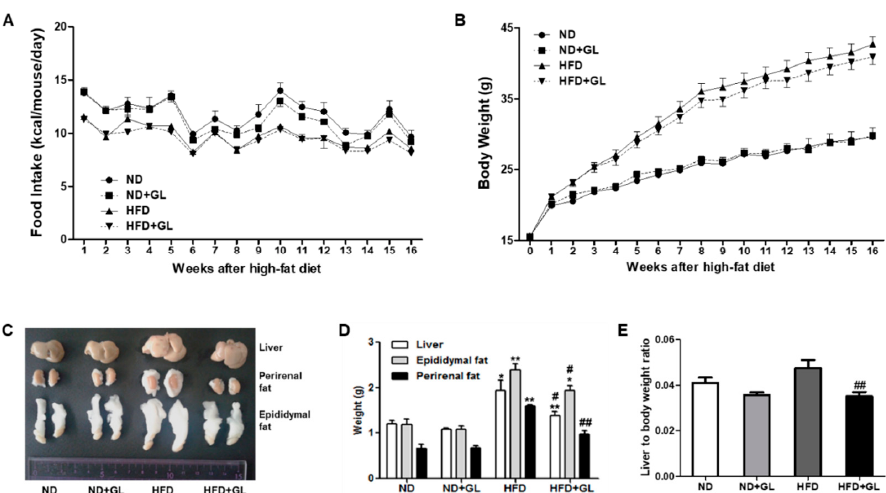
Figure 1. Ganoderma lucidum (GL) attenuated the increase in liver weight and epididymal and perirenal fat accumulation in high fat diet (HFD)-fed mice. ( A ) Food intake and ( B ) body weight for 16 weeks. ( C ) Representative images of liver, perirenal fat and epididymal fat and ( D ) the changes of the weight of liver, epididymal fat, and perirenal fat. ( E ) The ratio of liver weight to body weight. GL (50 mg/kg) or vehicle was orally administered five days/week in the mice fed with normal diet (ND) or HFD. Food intake was measured every ten days for 16 weeks. The mice were sacrificed after 16 weeks of GL treatment and the tissues were weighed ( n = 8–9 for each group). Data are the mean ± SEM. * p < 0.05 and ** p < 0.01 vs. ND group; # p < 0.05 and ## p < 0.01 vs. HFD group.